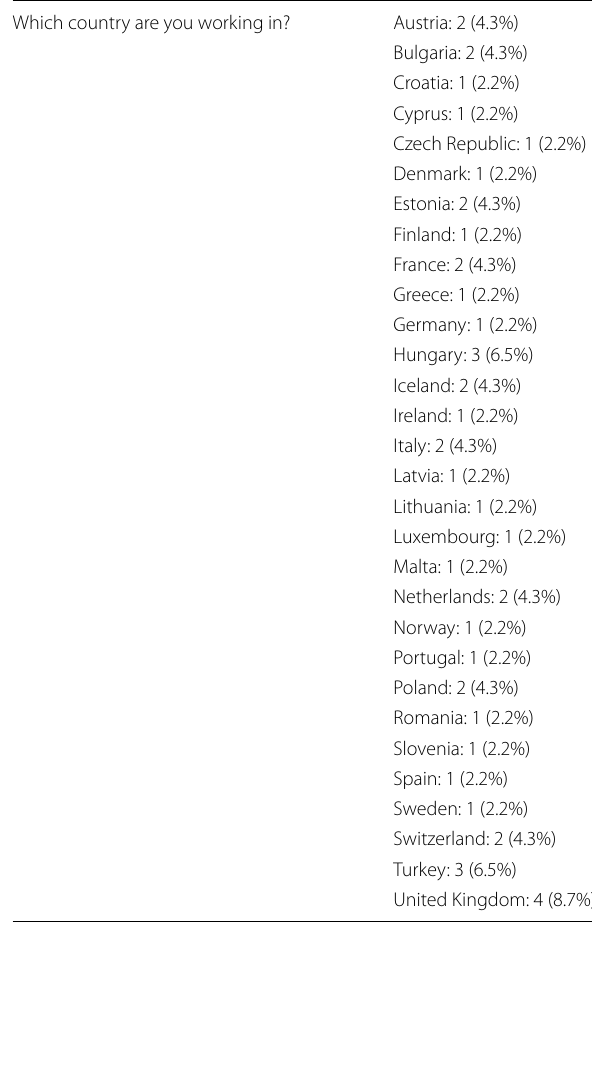
Table 2 The distribution of completed surveys stratified by country Which country are you working in?